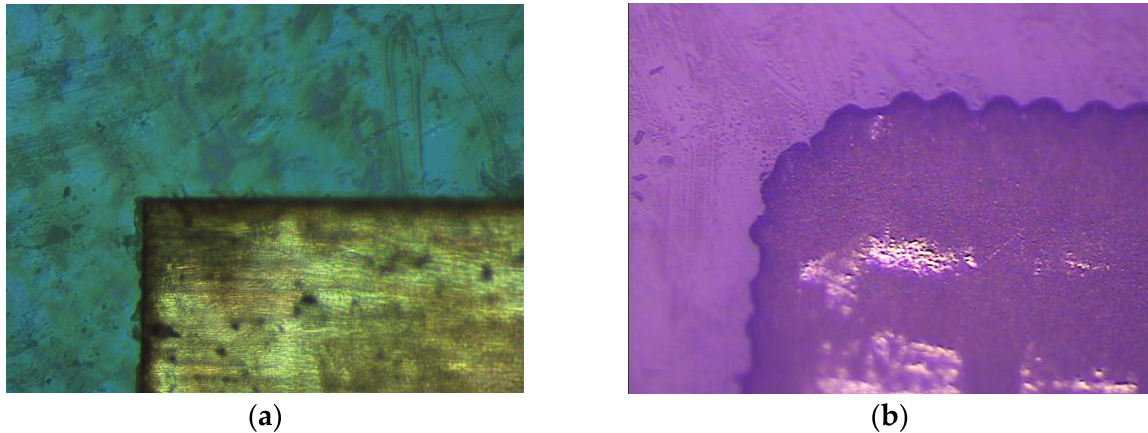
Figure 7. Microscopic images of the radiation patch edge. ( a ) Laser etching technology for case 1 antenna: ( b ) printing technology for case 4 antenna.